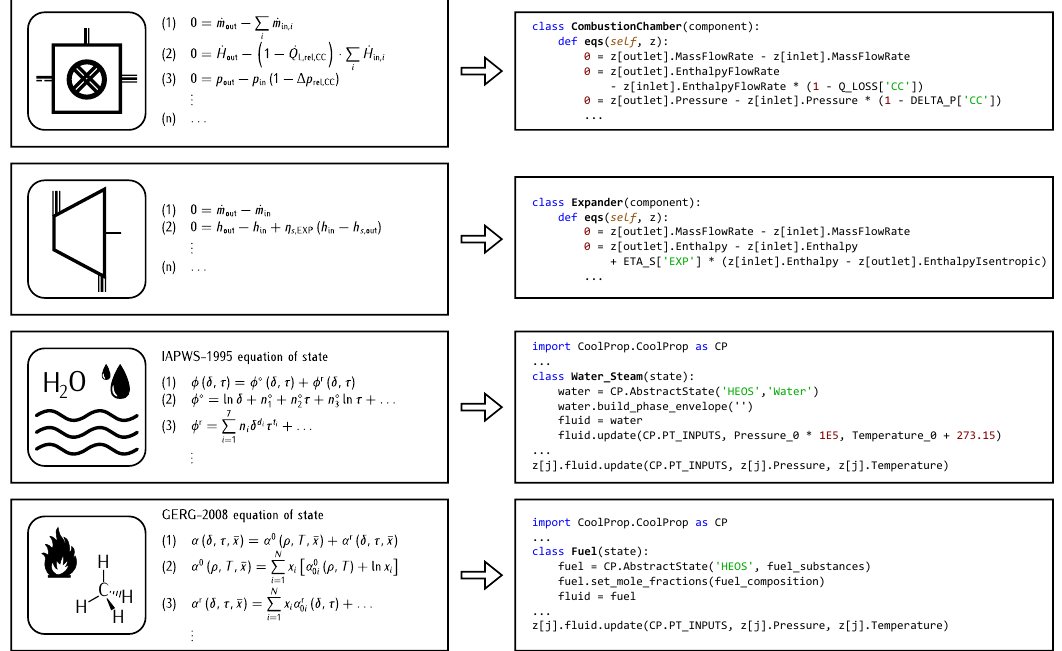
Figure 3. Implementation of thermodynamic balances and fluid properties as methods of component and state classes. Nomenclature for IAPWS and GERG formulation, see